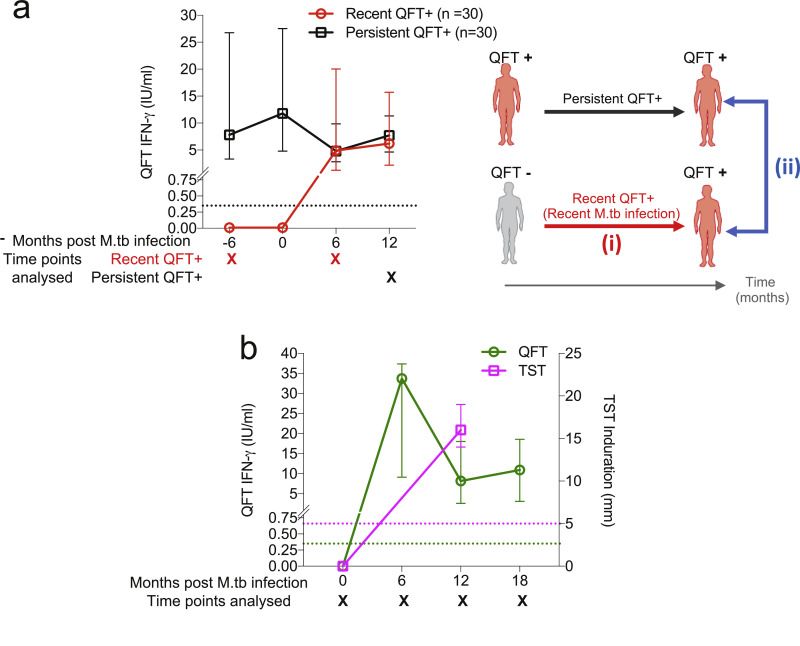
Longitudinal QFT (and TST) kinetics in the biomarker discovery and tetramer cohorts. M.tb infection was defined using longitudinal (a) QFT (only) results for the biomarker discovery cohort [recent QFT+ (red symbols, n=30 for all time points) and persistent QFT+ (black symbols, n= 30 for all time points)], and (b) both QFT (green) and TST (magenta) results for the tetramer cohort (n=11 for all time points). Longitudinal QFT+ and TST results are depicted as median with an interquartile range (IQR). Dotted lines indicate the assay positivity cut-offs. Only samples collected at time points marked with “X” were analysed in this study. The image in (a) depicts comparisons that were performed on the biomarker discovery cohort: (i) QFT− vs recent QFT+ and (ii) recent vs persistent QFT+.